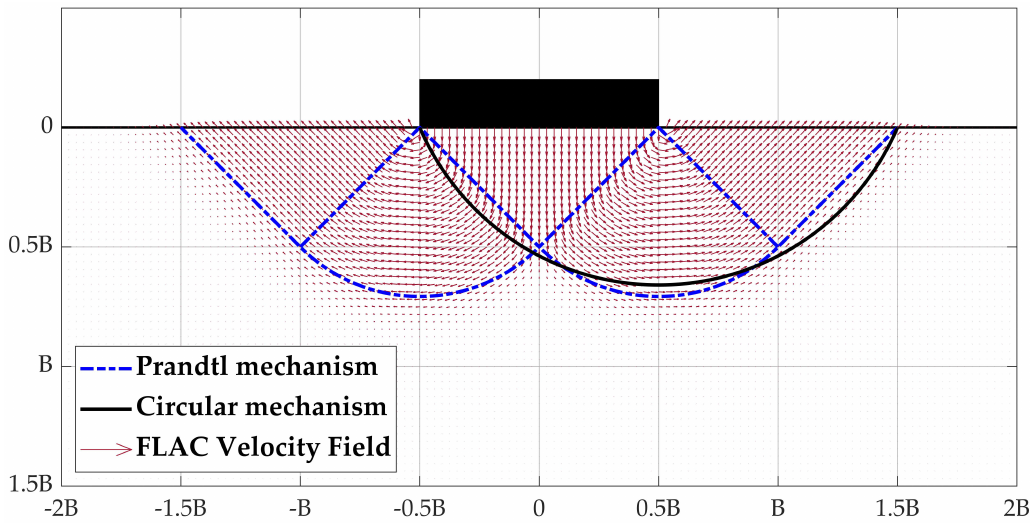
Figure 8. Perfectly rough footing velocity field at the numerical limit load ( kB / S u 0 = 0.0).